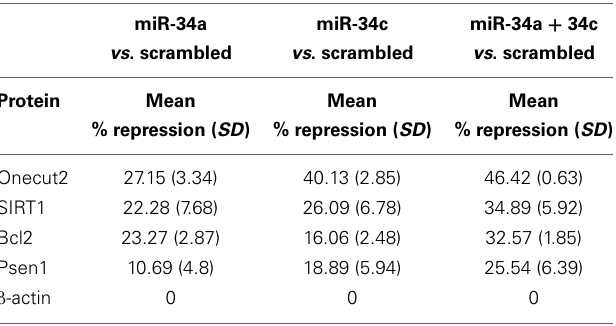
FIGURE 8 | Repression of expression of selected candidate target genes of miR-34a and miR-34c by transfection analysis. Human embryonic kidney (HEK 293) cultures were transfected with green fluorescence protein (GFP) expression vectors containing sequences encoding miR-34a, miR-34c, or a scrambled sequence. Controls included un-infected cultures, mock transfected cultures, cells transfected with either GFP vector alone or carrying a computer-generated scrambled sequence. (A) Western blot analysis of cell lysates probed for SIRT1, Onecut2, Presenilin-1, Bcl2, and Table 7 | Levels of miR-34a and miR-34c repression of four target genes’